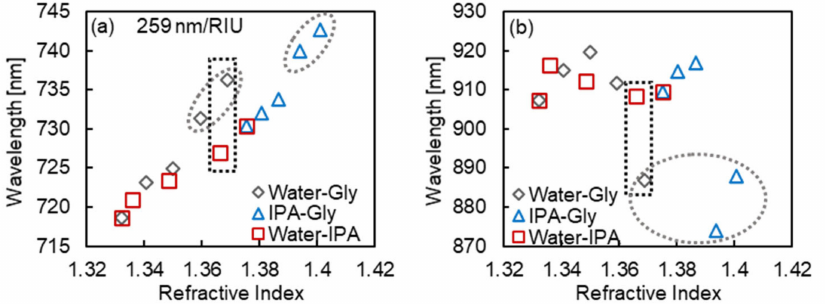
Figure 8. Absorption peak wavelength of the peak at ( a ) the shorter wavelength and ( b ) the longer wavelength of the fabricated MIM nanostructures, depending on the RI values of surrounding sample solutions. The gray hollow diamonds indicate the plots for 0–32 wt.% glycerol aqueous solution (Water-Gly), the blue hollow triangles indicate the plots for 0–32 wt.% glycerol-IPA mixture solution (IPA-Gly), and the red hollow squares indicate the plots for 0–100 wt.% IPA aqueous solution (Water- IPA). The gray dashed ellipses in ( a ) indicate the outliers, which might be attributed to the adsorption of glycerol. The gray dashed ellipse in ( b ) indicates the large shift to the shorter wavelength in the condition of high glycerol concentration. The black dashed squares show the plots for 32 wt.% glycerol aqueous solution ( n = 1.3690) and 50 wt.% IPA aqueous solution ( n = 1.3661), in which the two absorption peaks showed completely different responses toward similar RI values of the